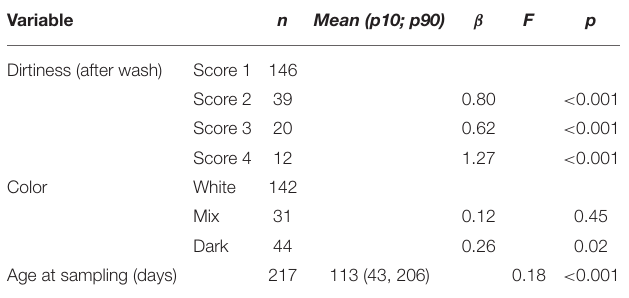
TABLE 2 | Results of the final generalized additive mixed model on the effect of dirtiness, hair color, storage, and other laboratory-related factors on hair cortisol extracted from hair samples.